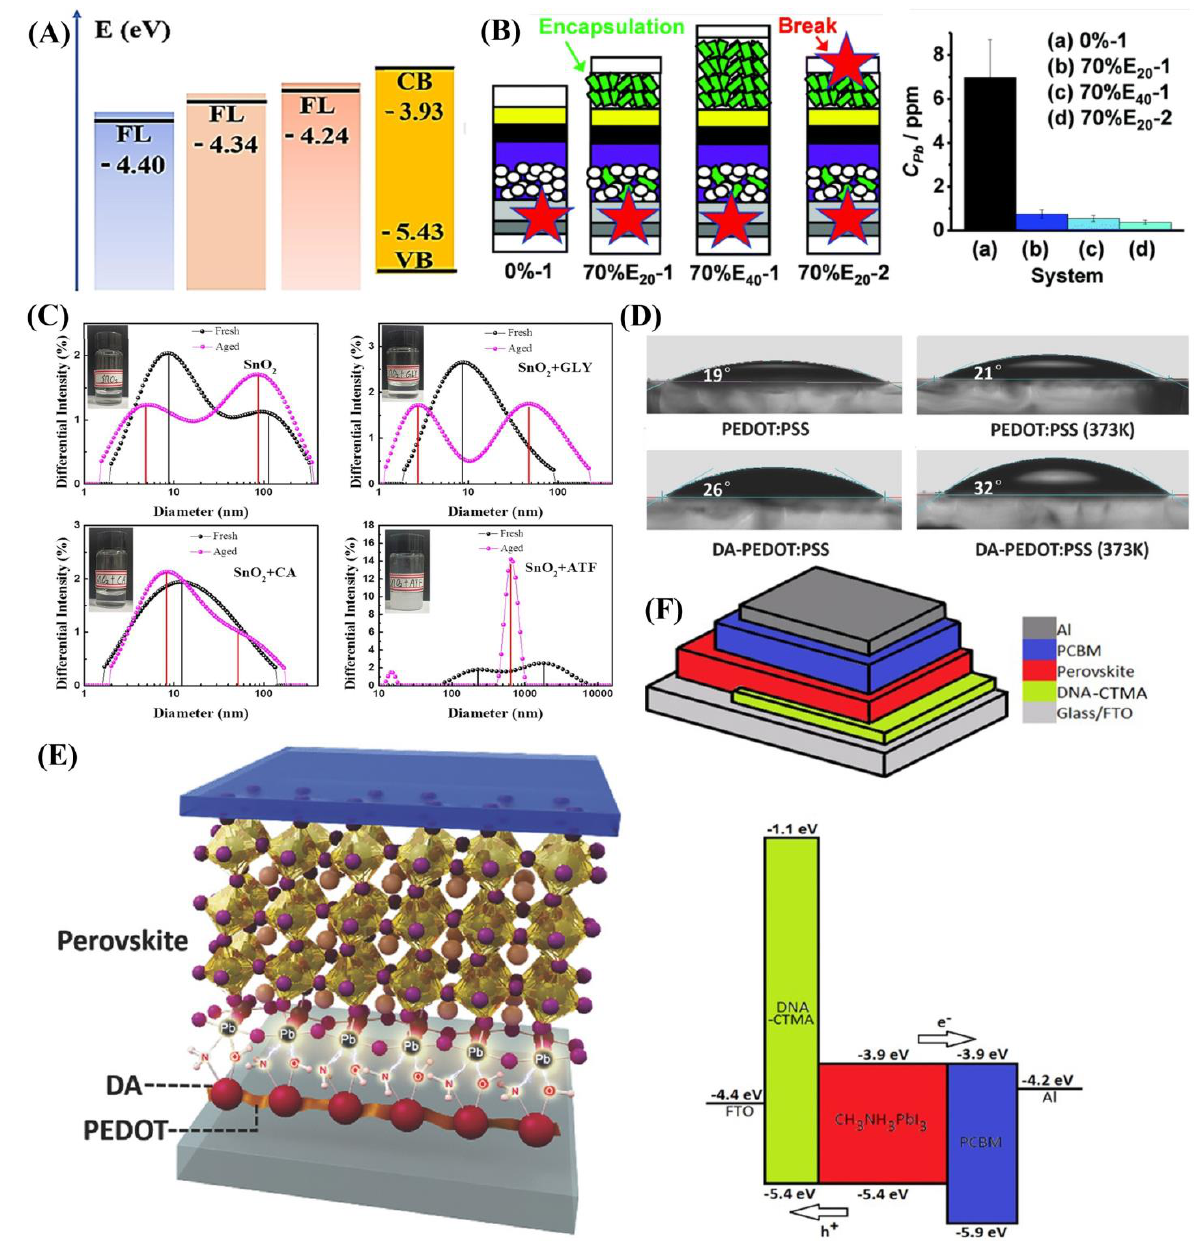
Figure 3. Instances of natural molecule-modified CTLs. ( A ) Schematic illustration of the energy